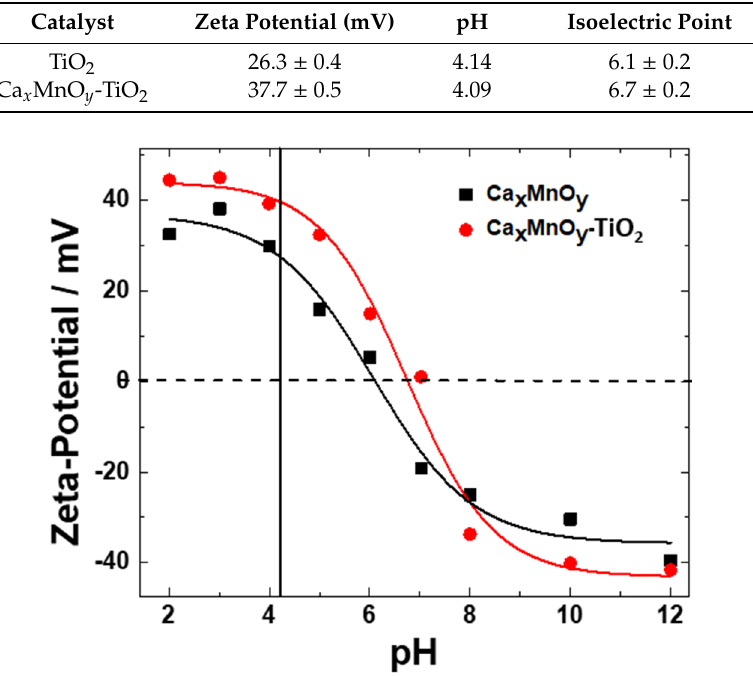
Figure 6. Zeta potentials at different pH in 1 mM KCl.